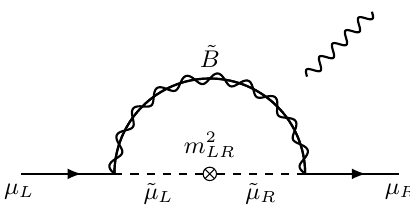
Figure 1 . Bino-smuon contribution to the muon g (cid:0)